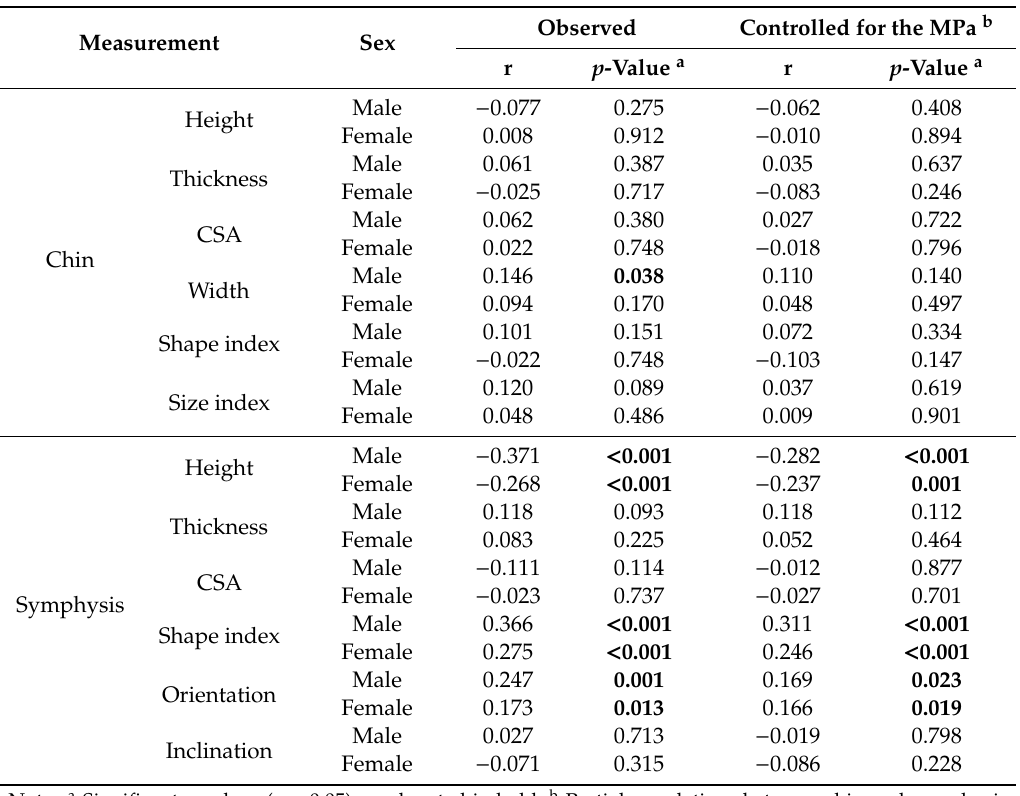
Table 3. Correlation coe ffi cients between the chin and symphysis parameters and age by sex (males n = 203, females n =